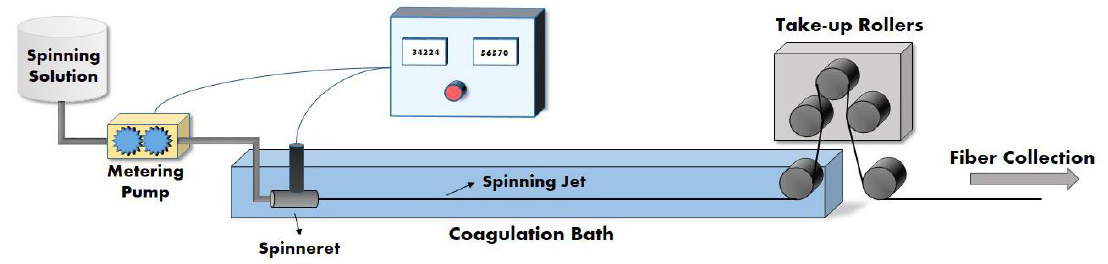
Figure 1. Schematic diagram of the wet spinning machine used in the present work.